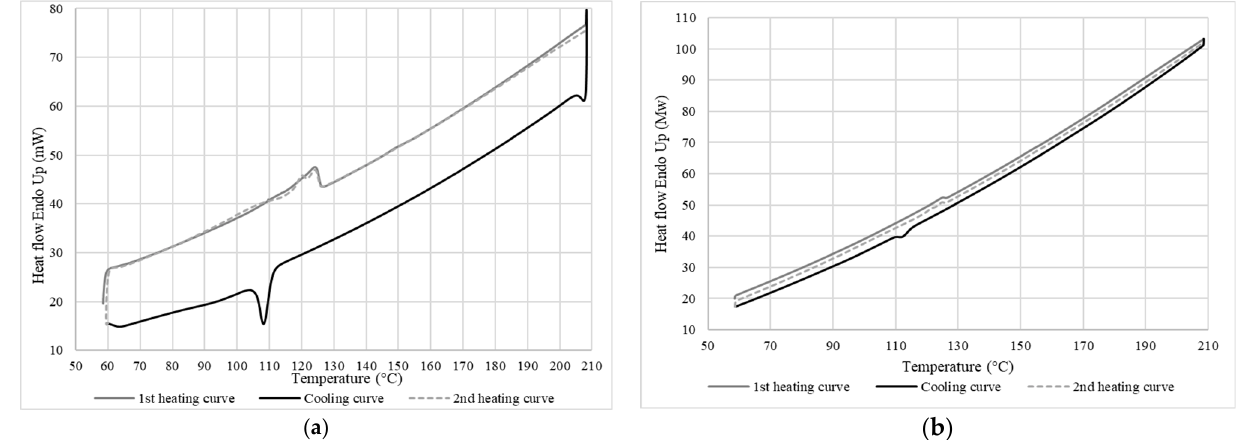
Figure 6. DSC curves of the corn starch (10 °C/min).